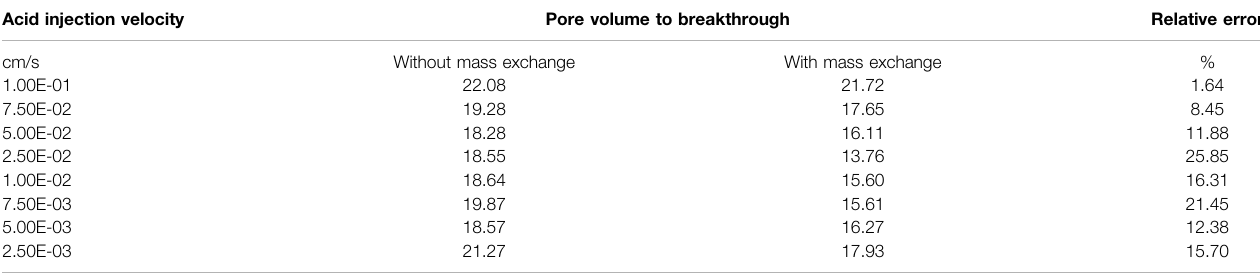
TABLE 2 | Effect of mass transfer term on acidizing results of isolated fracture core sample.